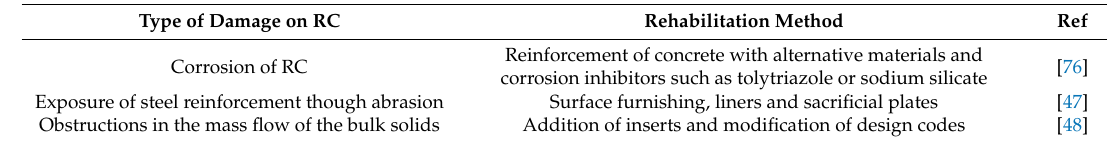
Table 8. Rehabilitation of deteriorated